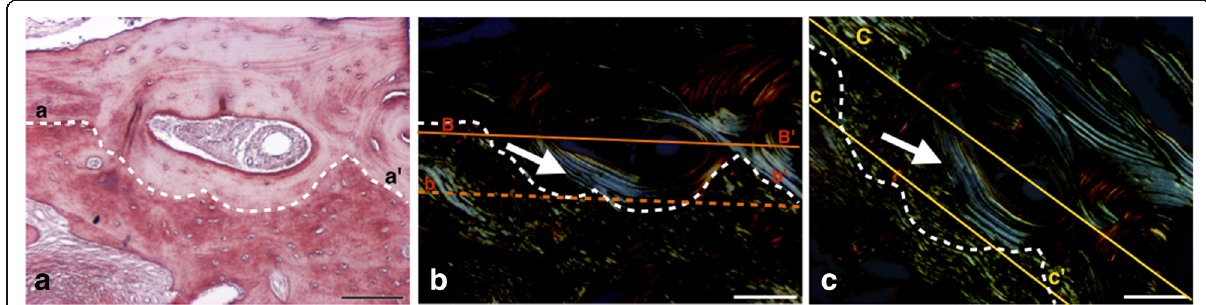
Fig. 4 Histomicrograph of a biopsy from the BC group, showing an aspect of newly formed bone. Section stained with picrosirius-hematoxylin and digitalized with bright-field ( a ) and linearly polarized light ( b and c ). b , c Results of near 45° section rotation (between axes B – B ’ and C – C ’ ) to compensate some of the orientation-related effects associated with linearly polarized light. In a , typical Haversian systems are showed (area observed above dotted line , a to a ’ ). In b and c , the arrows indicate thin birefringent collagen bundle (appearing as bright lines ) arranged around Haversian canals, suggestive of mature lamellar bone. The area observed below the dotted line is suggestive of immature (non-lamellar) bone, where collagen fibers undulations can be observed. The dark area corresponds to complete disorganization of the collagen fibers. Bar = 100 μ m